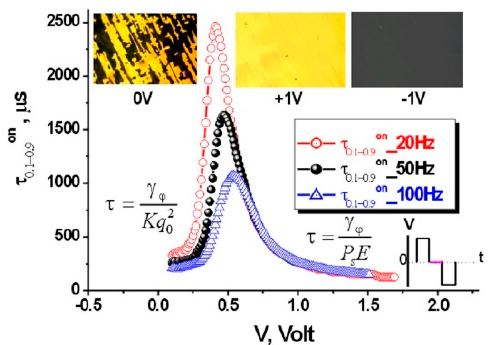
Figure 5. Dependence of switching on time of 1.5 µ m cell filled with the FLC-595 [28,33]. Insertions: